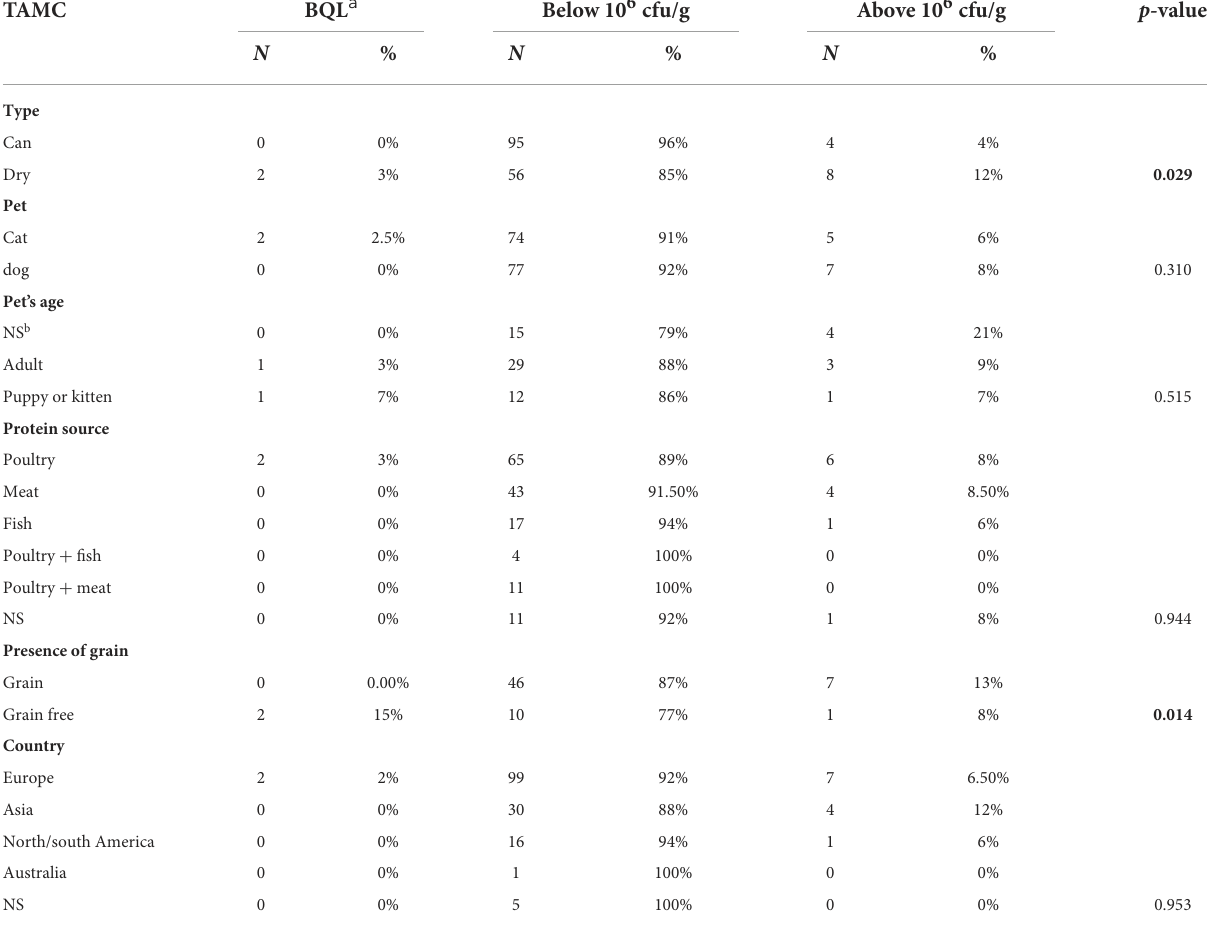
TABLE 2 Microbiological results of Total Aerobic Microbial Count in dry and canned pet food.